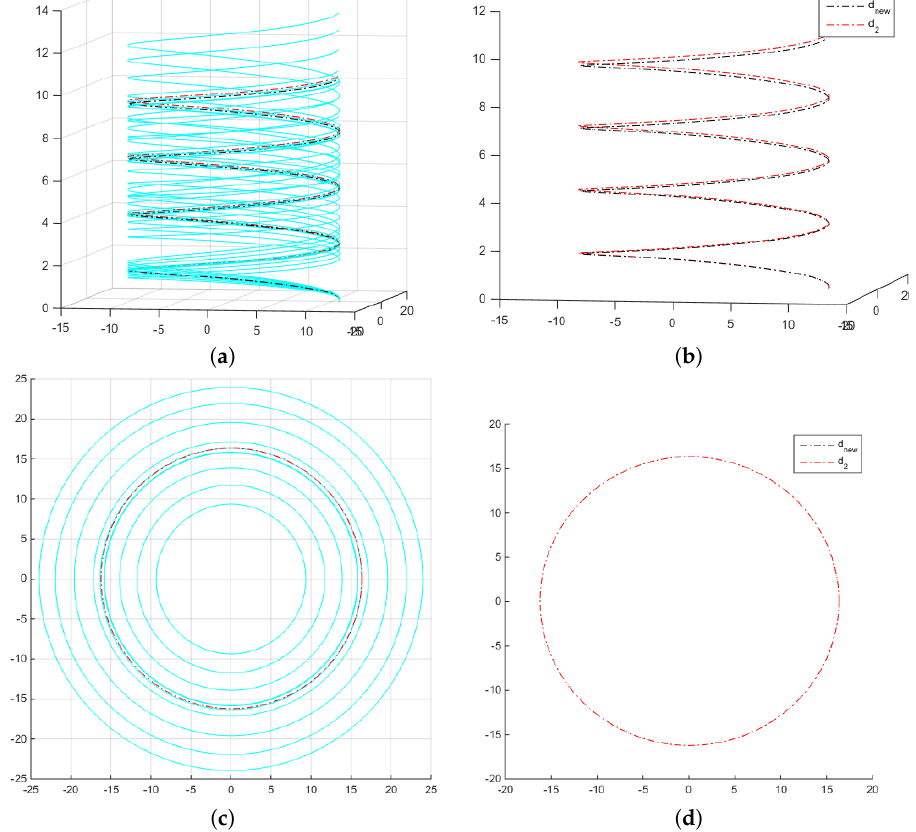
Figure 2. ( a , c ) Simulated curves and their corresponding means. ( b , d ) Comparison of the Karcher means obtained with the two different